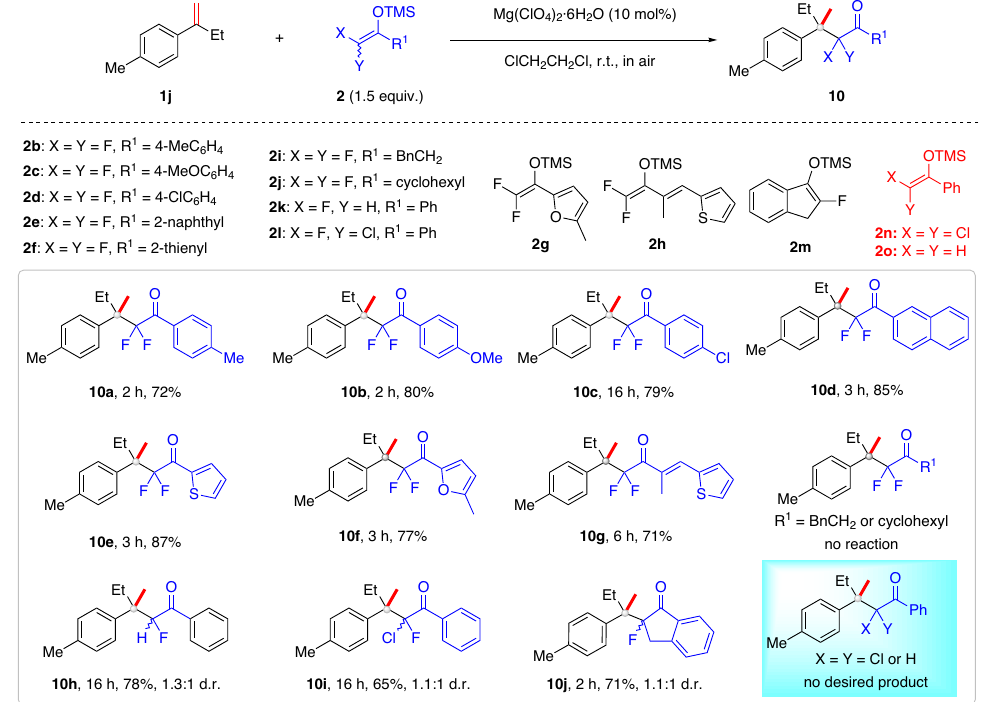
Fig. 4 Scope of silyl enol ether 2 and the fl uorine effect. Reaction conditions: alkene 1j (0.3 mmol), 2 (0.45 mmol), Mg(ClO 4 ) 2 ‧ 6H 2 O (10 mol%), and ClCH 2 CH 2 Cl (3 mL) in air at room